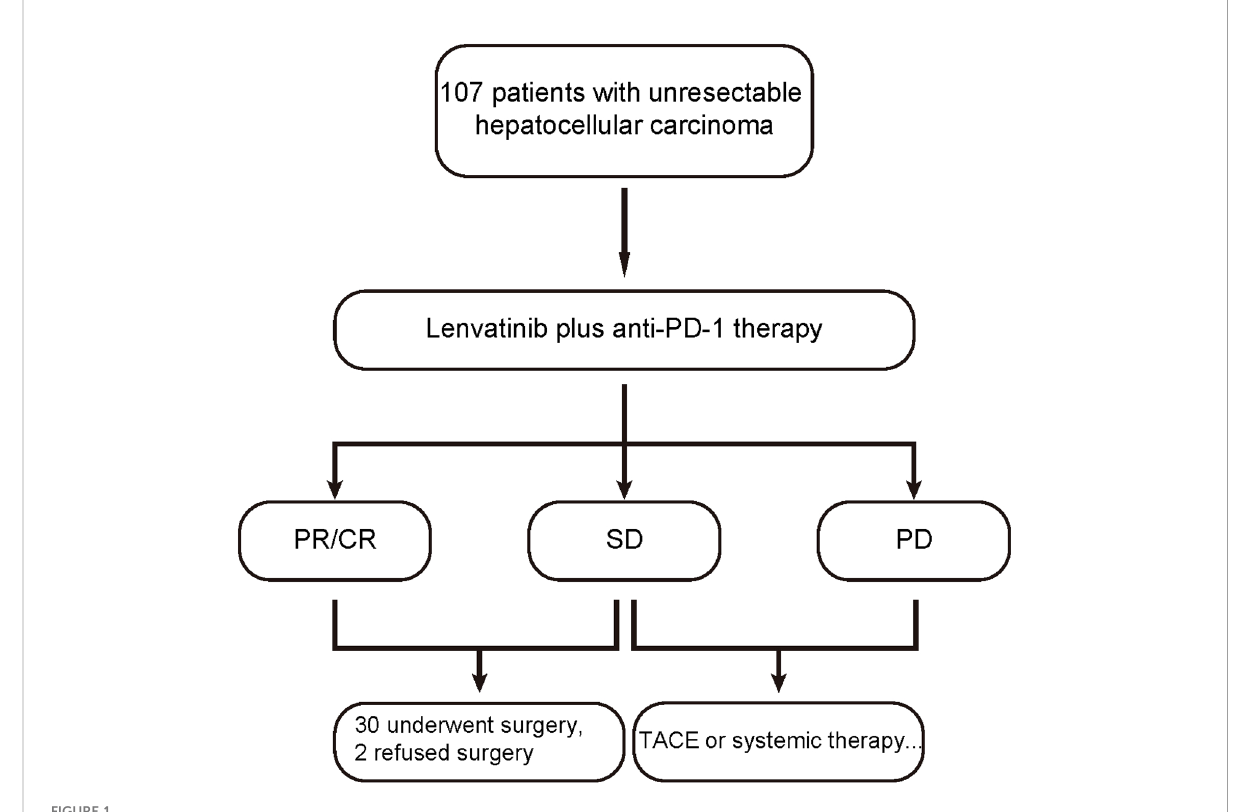
FIGURE 1 Patient fl